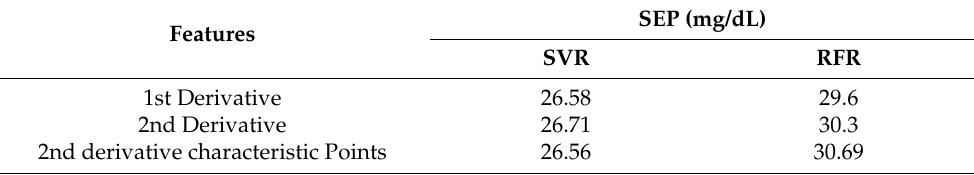
Table 7. Subject wise glucose level prediction error using SVR and RFR